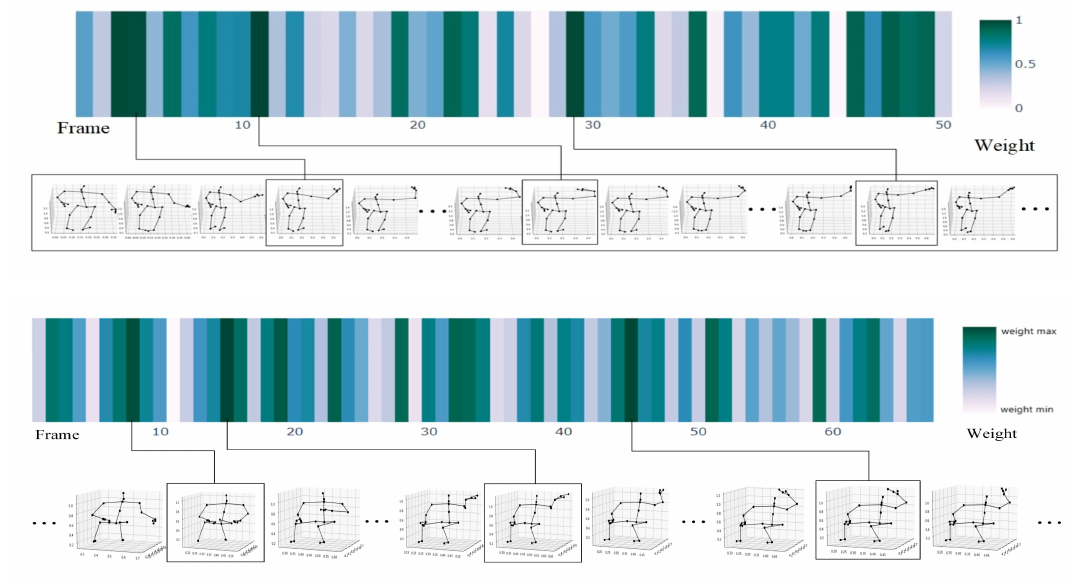
Figure 4. Distribution of attention weights and visualization of keyframes. The picture shows the frames with top 3 weights in the “waving” action.